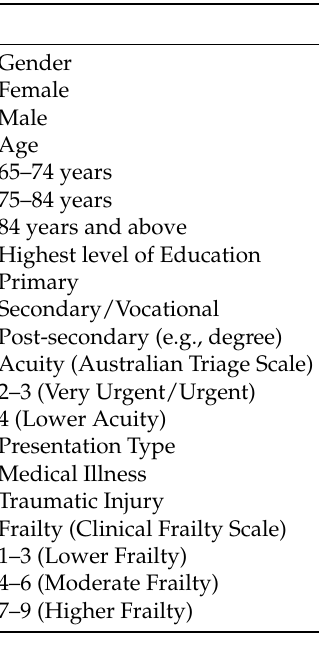
Table 4. Summary of participant